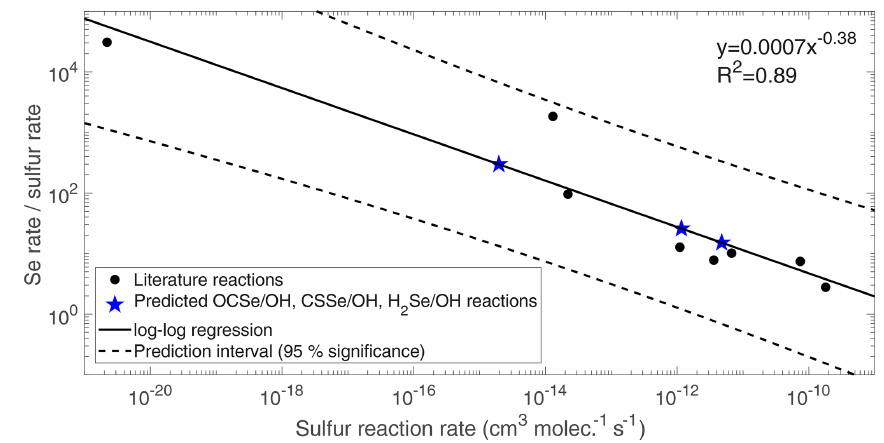
Figure 2. Estimation of unknown Se reaction rates from the analogous S reaction rate. A power regression is performed, with statistics shown in the upper right corner of the plot. For the H 2 S + O 3 reaction only an upper limit estimate was available, and therefore it was not included in the